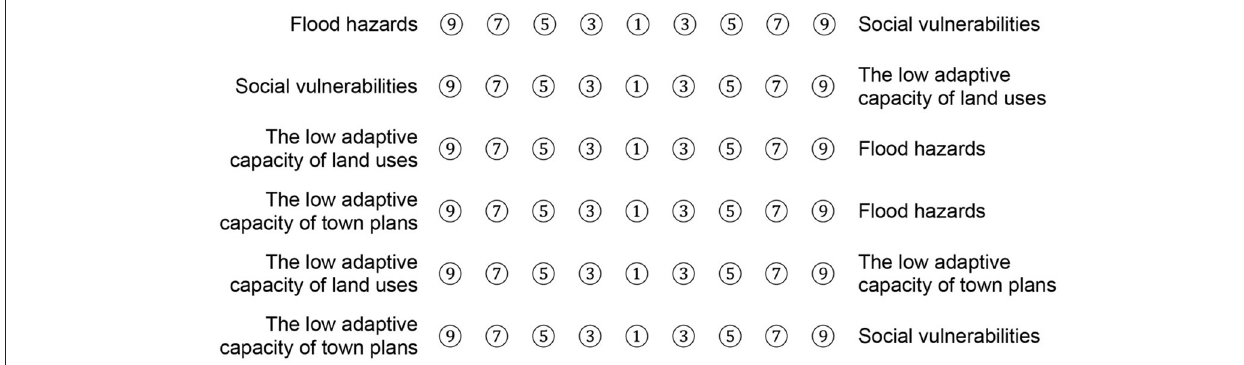
Ratio ( C . R .); where the value of the C . R . for a matrix with the size of four is proposed to be 0.9 by Saaty (1990). Considering these consistency criteria, we filtered the responses and calculated the weight of concepts corresponding to each participant. The final weights of concepts are the average of weights obtained for each